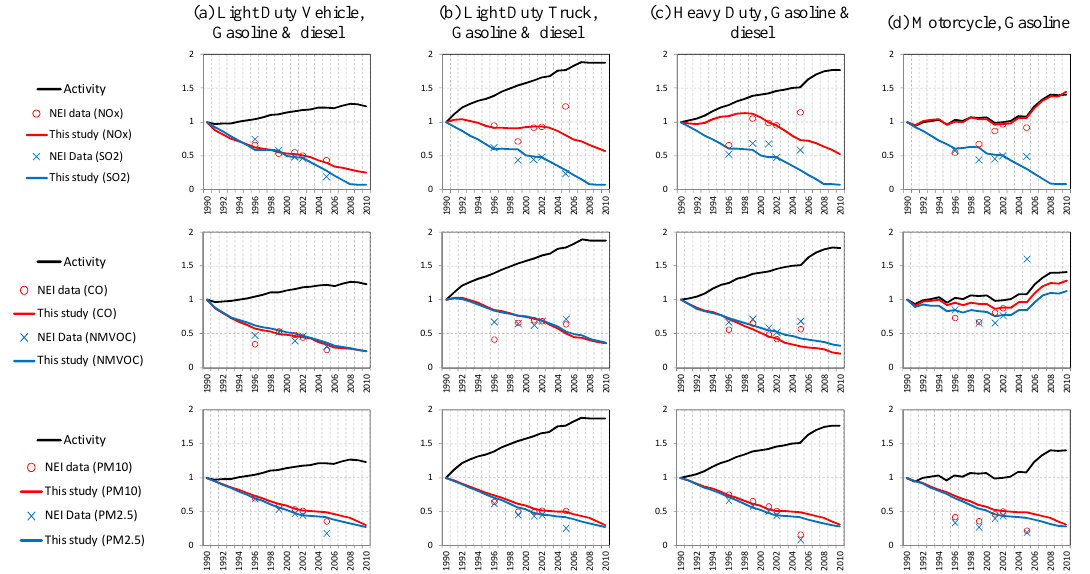
Fig. 5. Activity and emission trends during 1990–2010 for on-road mobile sources (year 1990 = 1; absolute values are provided in Table S2b). Fig. 5 Activity and emission trends during 1990-2010 for on-road mobile sources (Year 1990 =1, absolute values are provided in Table S2b)